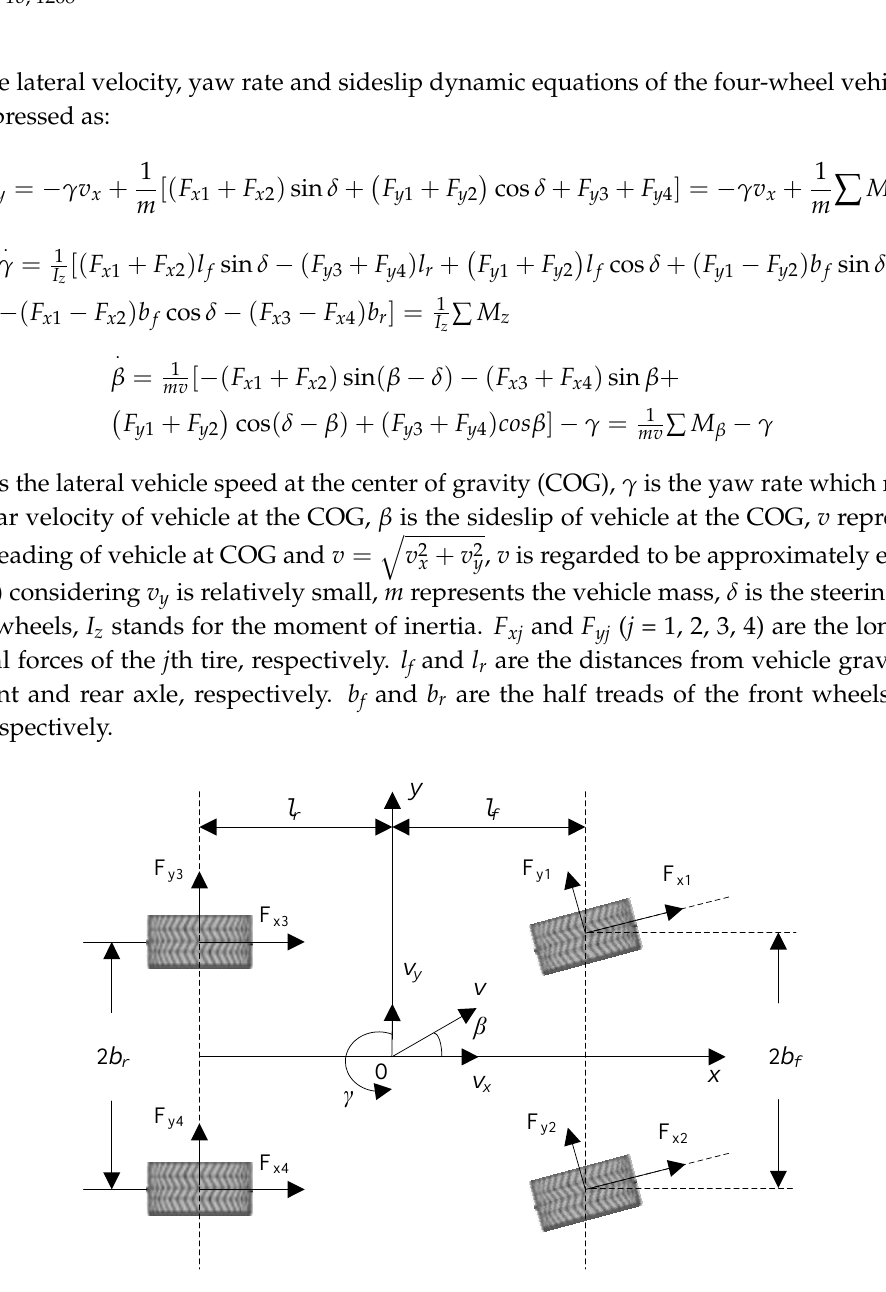
Figure 1. Vehicle model.